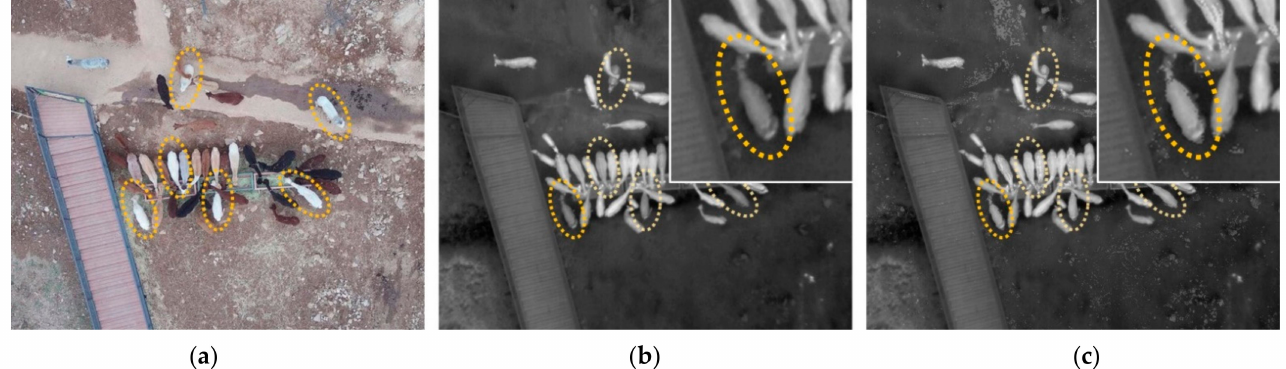
Figure 5. Example of thermal image correction (fur color). ( a ) Original RGB image, ( b ) original thermal image, and ( c ) corrected thermal